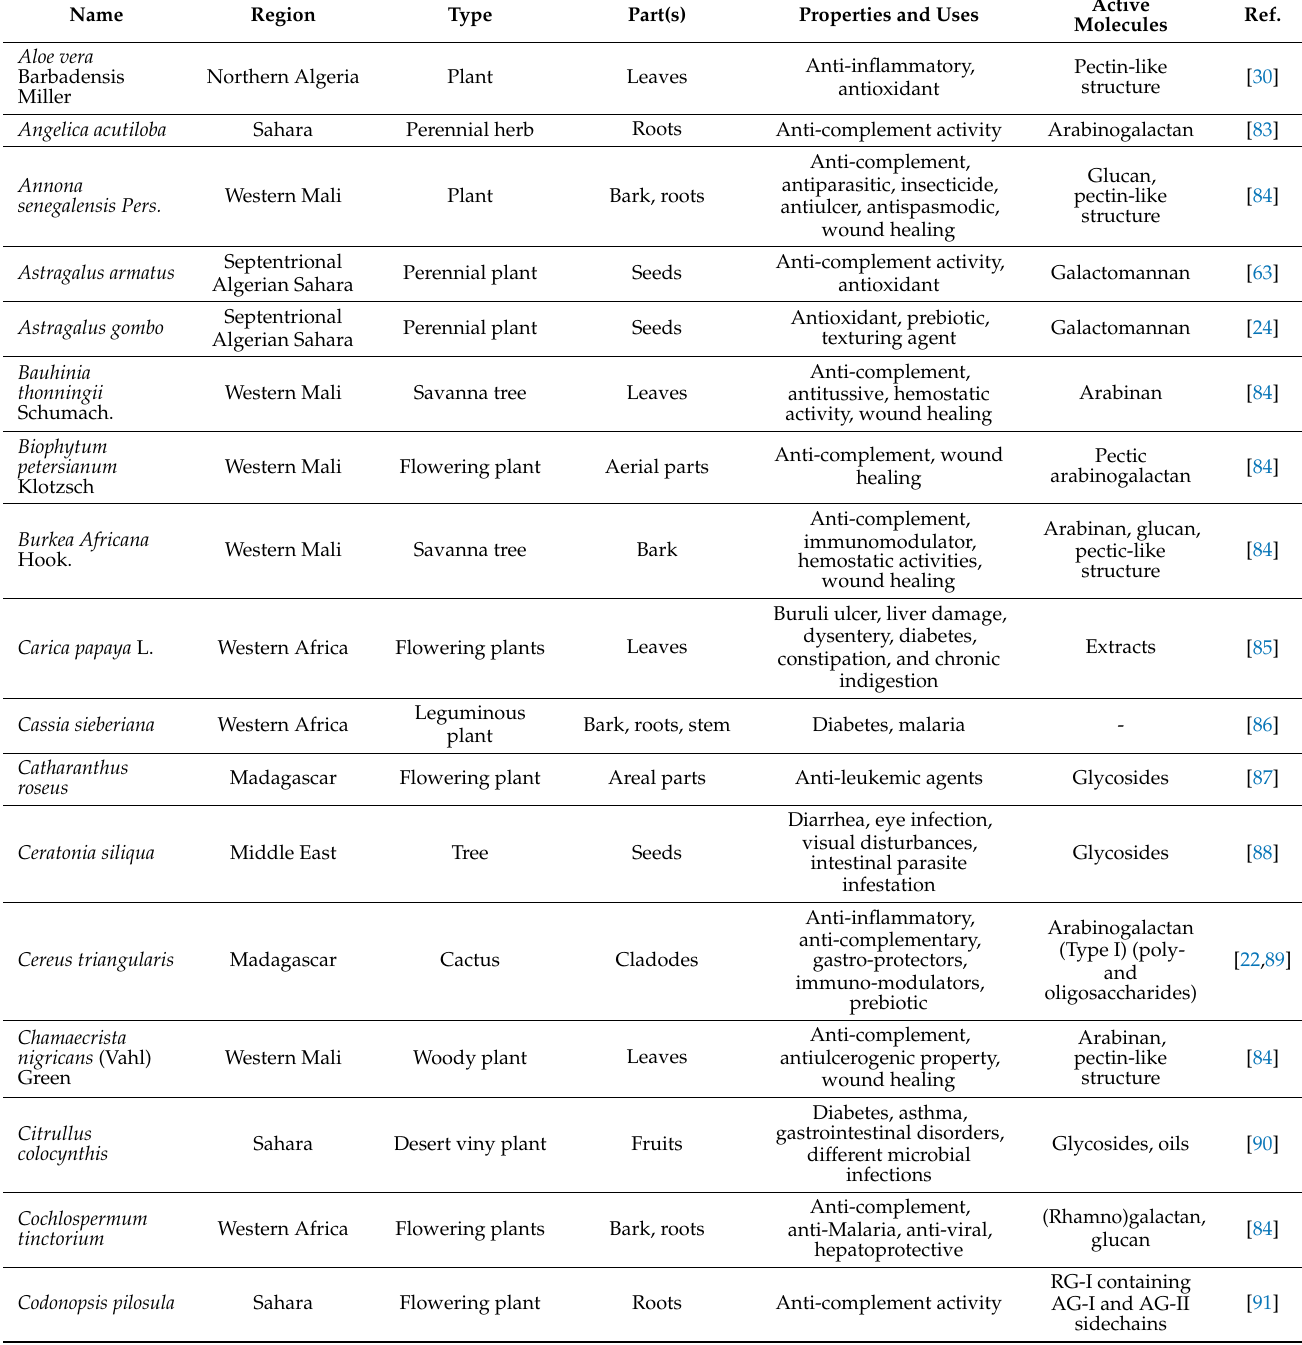
Table 2. Some African plants which were investigated regarding ethnobotanical and/or ethnopharmaceutical